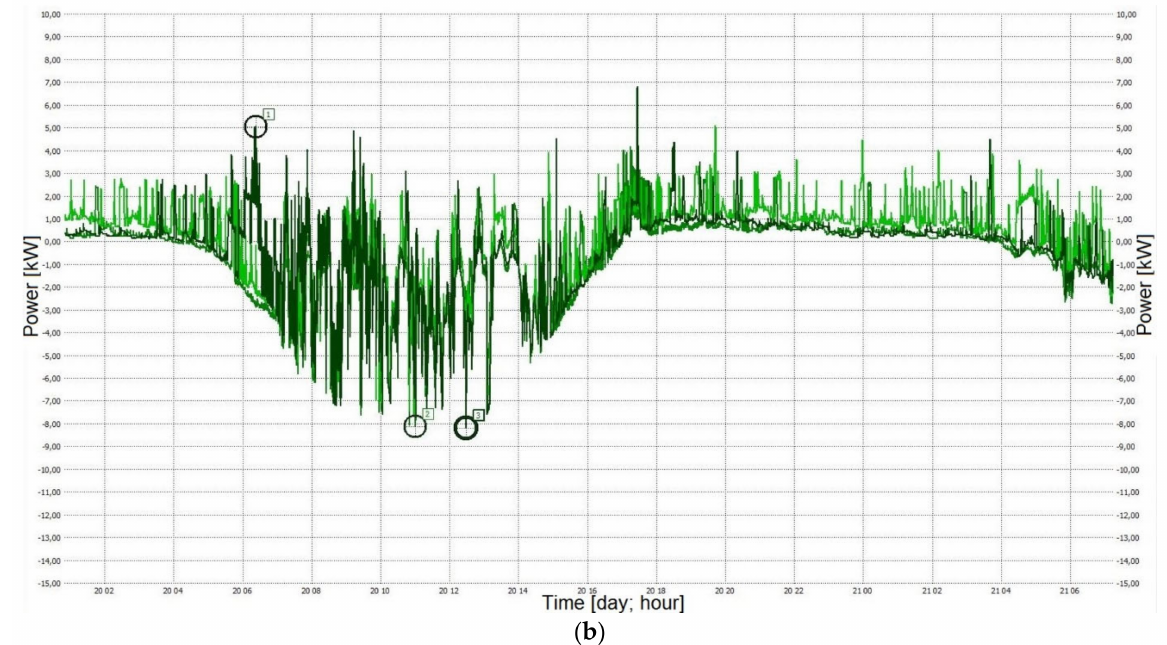
Figure 4. Voltage and active power variations in node 105 (period: 20 May 2021, hour 2:00 a.m. −